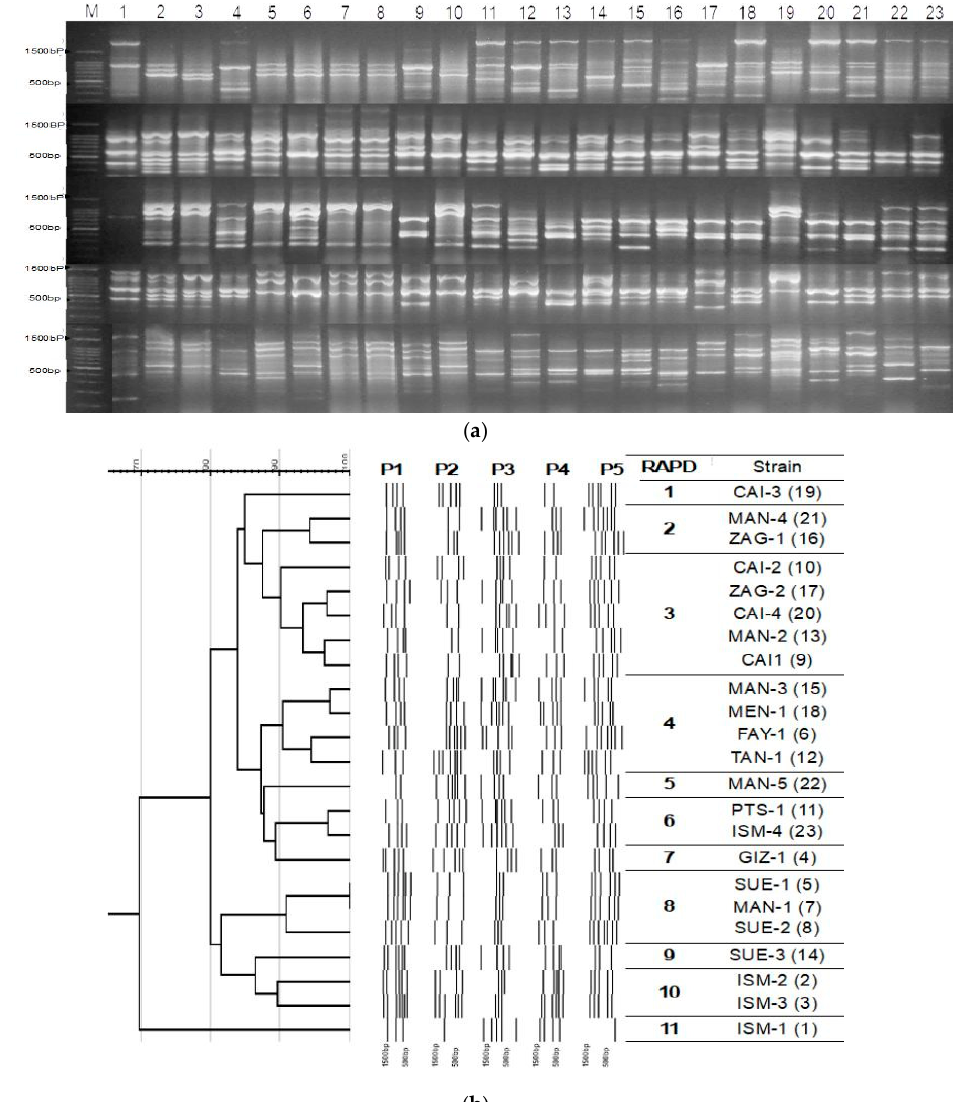
Figure 3. RAPD genotyping of the strains. ( a ) Combined RAPD patterns of 23 clinical Acinetobacter isolates obtained after electrophoresis of the PCRs with five different primers individually. For each primer, five RAPD gels were combined into one image. ( b ) RAPD dendrogram was constructed with GelJ cluster analysis software by Unweighted Pair Group Method with Arithmetic Mean ( UPGMA). Percentages of similarity and primers used as presented in Table 3 on the top line of the dendrogram. RAPD type and strain code as in Table 3 and strain numbers as presented in Figure 3a appear on the right (between parenthesis).